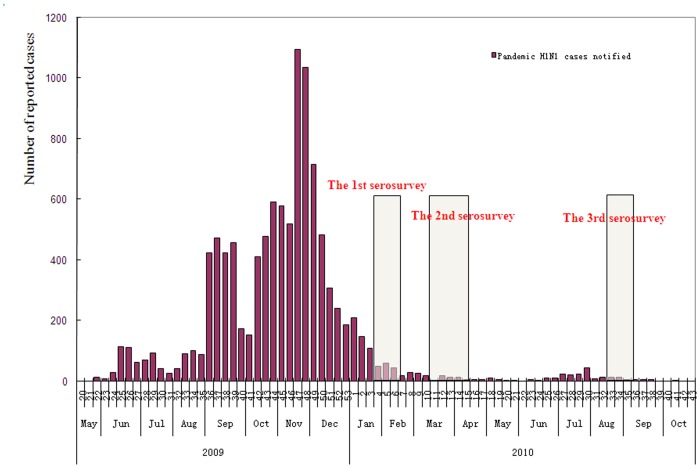
Sampling period for three serosurveys shown relative to epidemic curve in Guangdong China.Three surveys were consecutively carried out in 2010 during 9 months following the 2009 pandemic wave in Guangdong, China. Survey 1 were conducted from January 8 to January 24, survey 2 from March 15 to April 10 and survey 3 from August 23 to September 4.